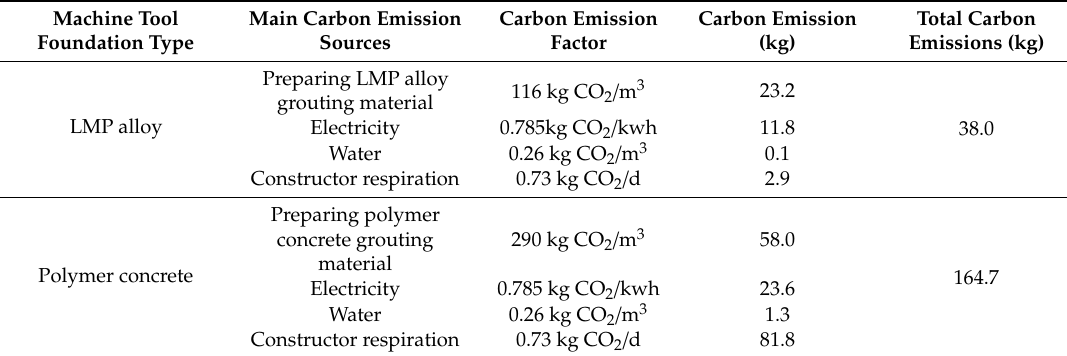
Table 7. Carbon emitted during the construction of a machine tool